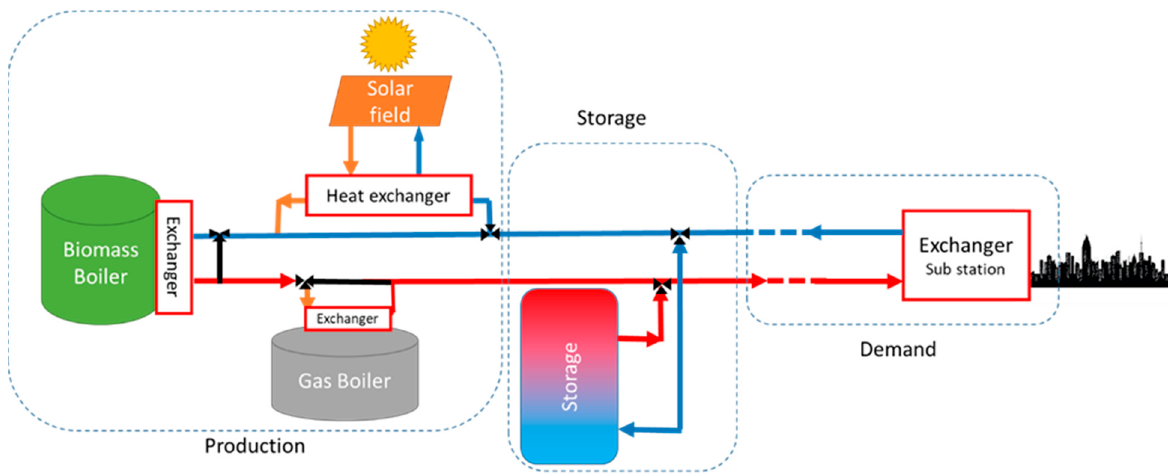
Figure 2. Diagram of the modeled system.